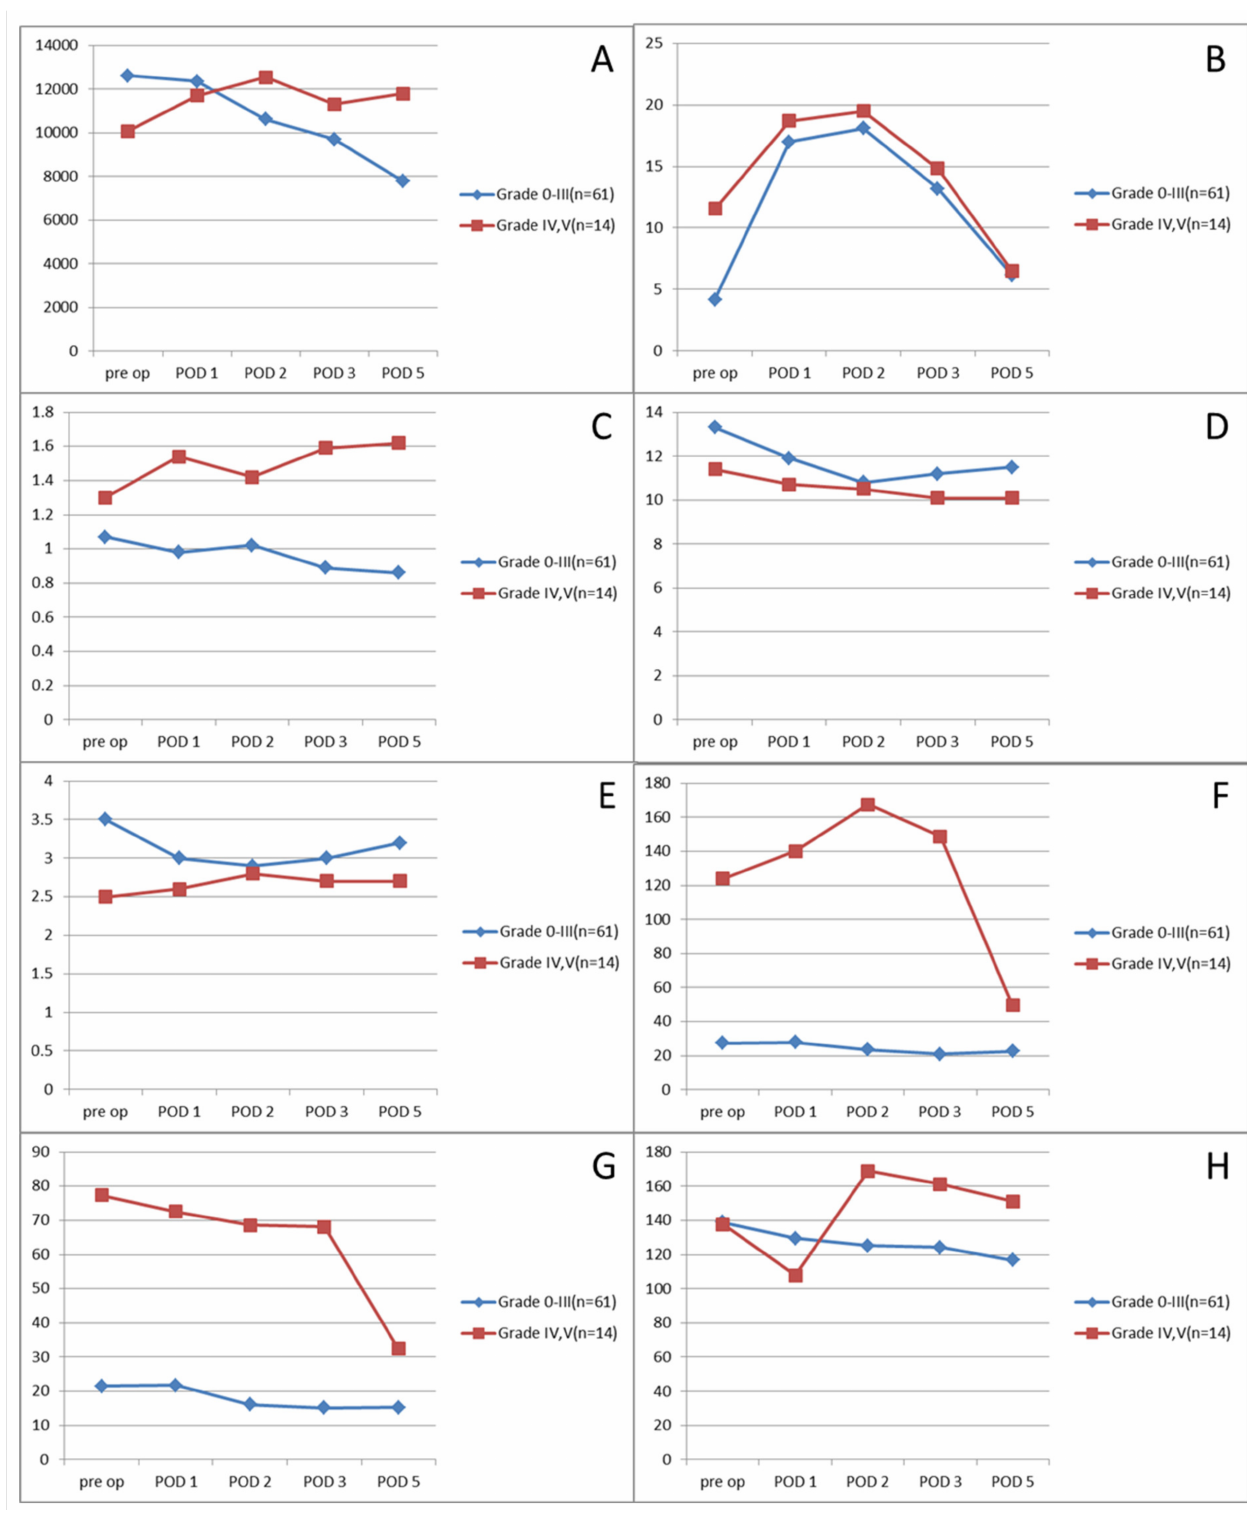
Figure 2. Selective laboratory findings according to the Clavien-Dindo classification. ( A ) WBC, ( B ) CRP, ( C ) creatinine, ( D ) hemoglobin, ( E ) albumin, ( F ) AST, ( G ) ALT, ( H )